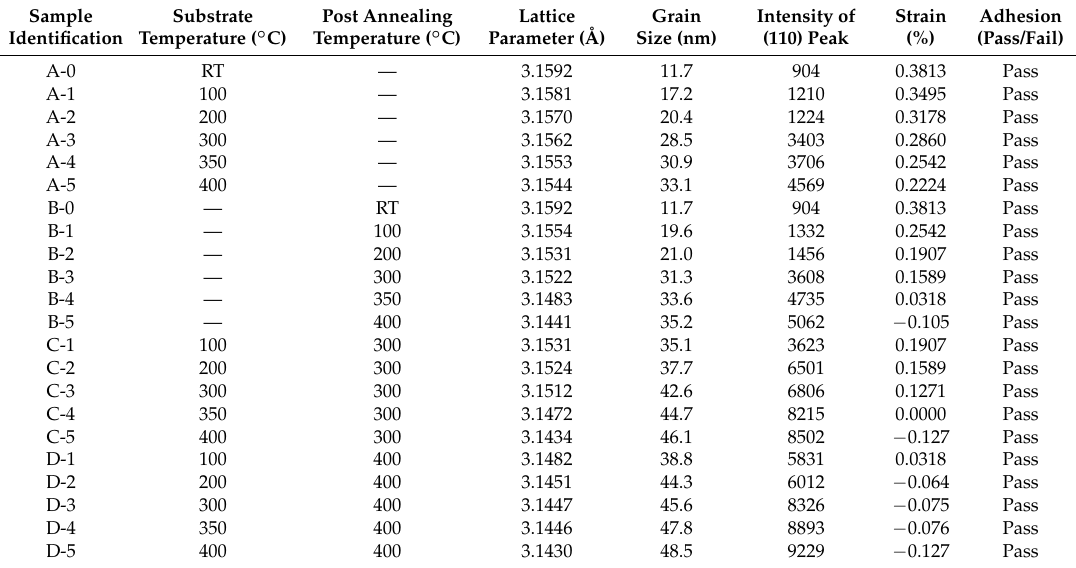
Table 1. Adhesion, lattice parameter, grain size, intensity of (110) peak and strain of Mo thin films prepared in different heating modes at different